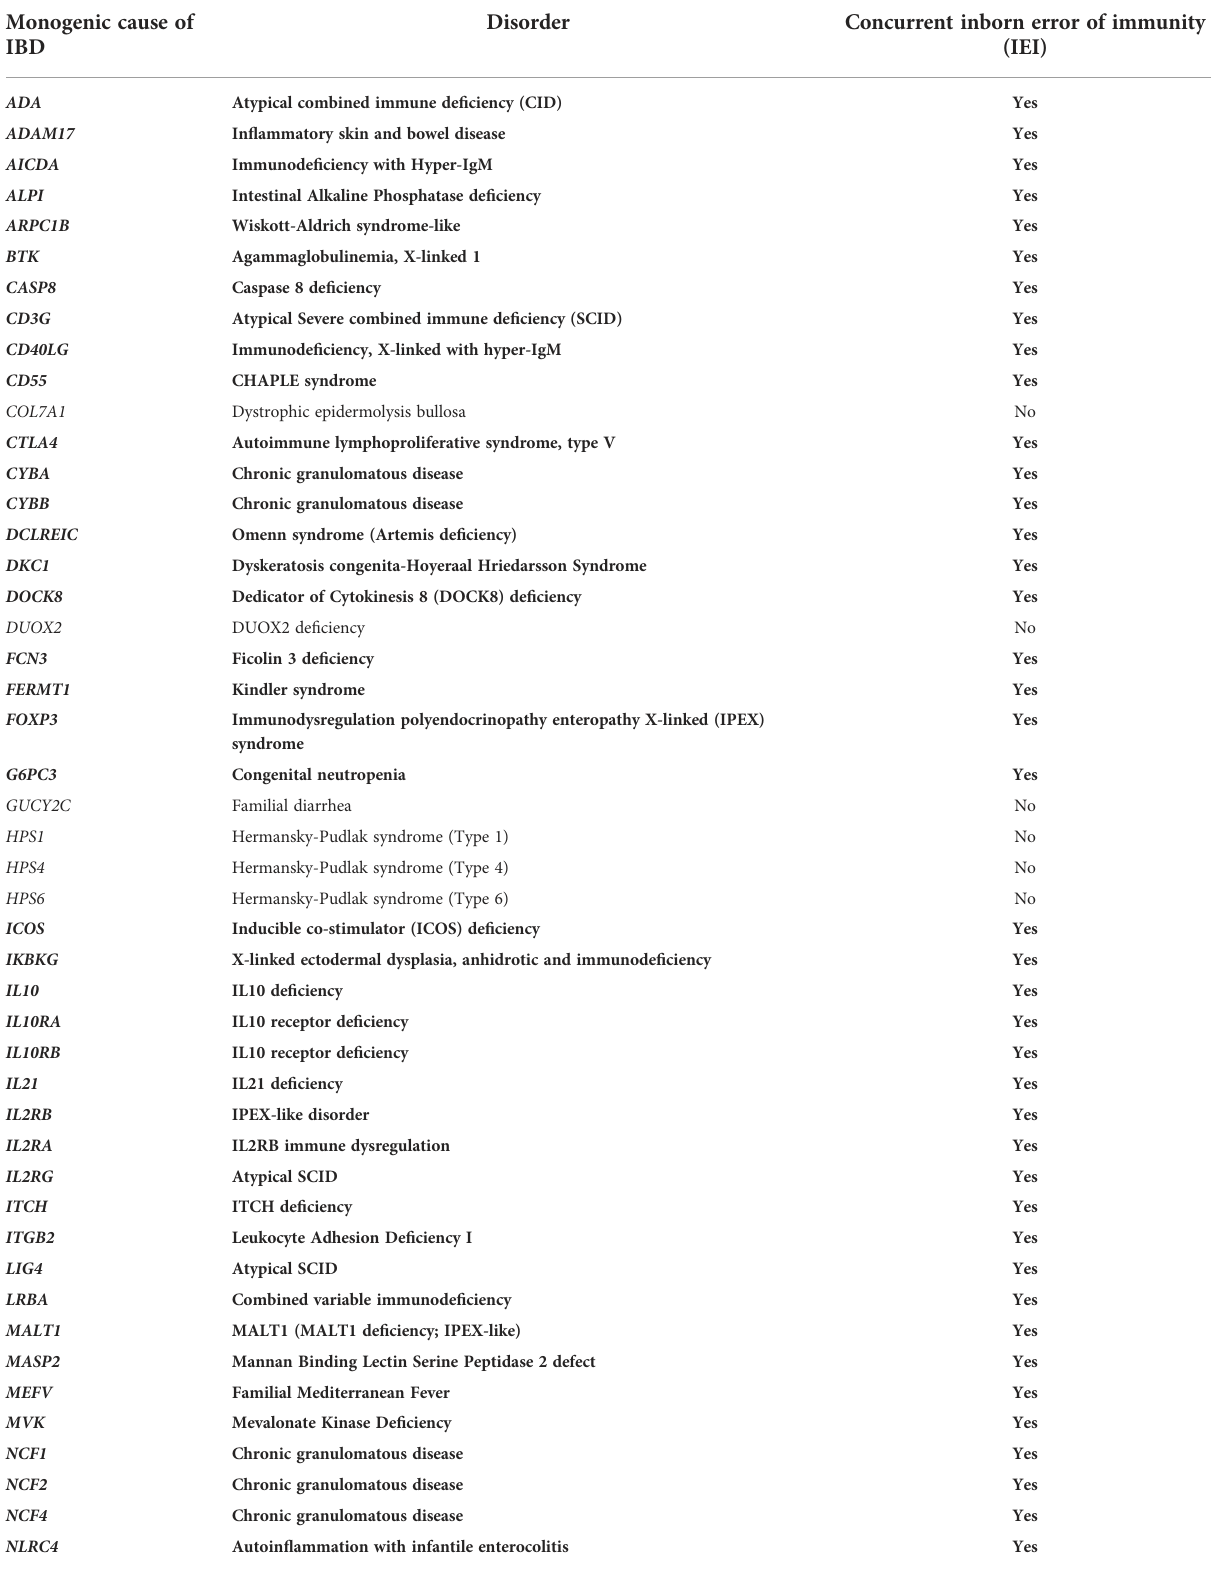
Disorder Concurrent inborn error of immunity